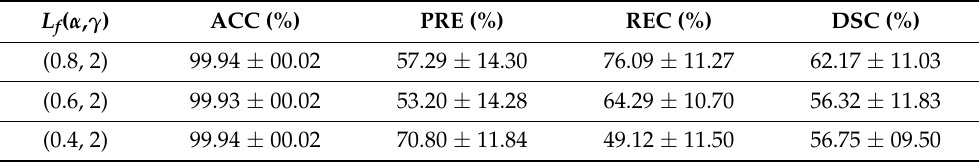
Table 4. ACC, PRE, REC, and DSC comparison of the segmentation with different parameters on focal loss function (compared with the manual ground